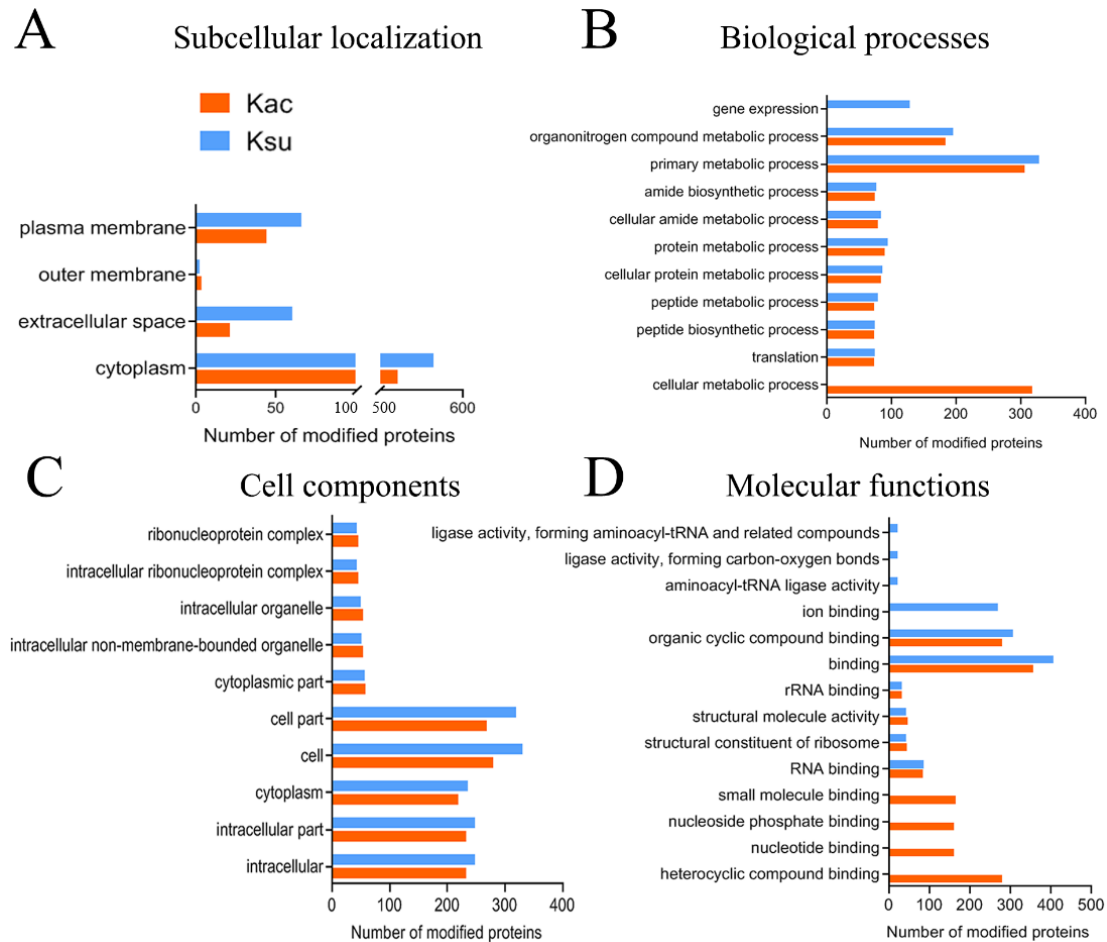
Figure 3. Subcellular localization prediction and GO annotation analysis of acetylated/succinylated- lysine proteins in E. tarda strain EIB 202. ( A ) Subcellular localization of the identified Kac and Ksu proteins. ( B – D ) GO annotation analysis of the identified Kac and Ksu proteins in terms of biological process, cell components, and molecular